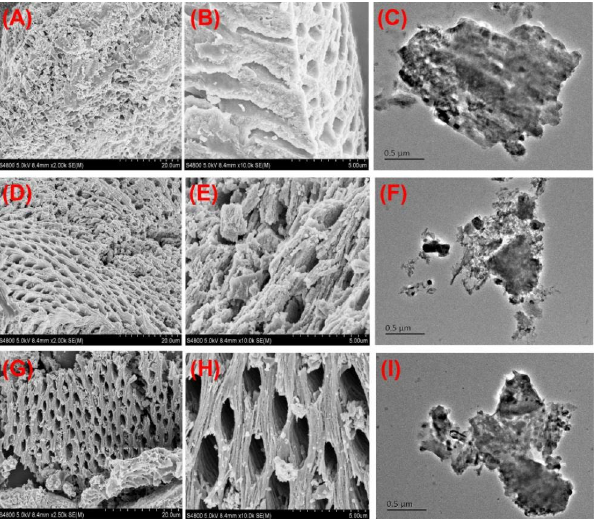
Fig. 1 Scanning electron microscope (SEM) images of CSB350 (A and B), CSB500 (D and E) and CSB650 (G and H); and the transmis- sion electron microscope (TEM) images of CSB350 (C), CSB500 (F) and CSB650 (I). CSB350, CSB500, and CSB650 indicate the crawfish shell biochars pyrolyzed at 350 °C, 500 °C, and 650 °C,